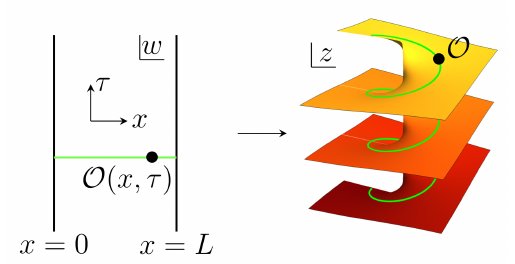
2 π qw / strip to the q -sheet z - Figure 2: Conformal map z = e L from the w -cylinder Riemann surface. For the coordinate w = τ + ix , x = L and x = 0 are either identified or imposed with conformal boundary conditions for a cylinder or strip,